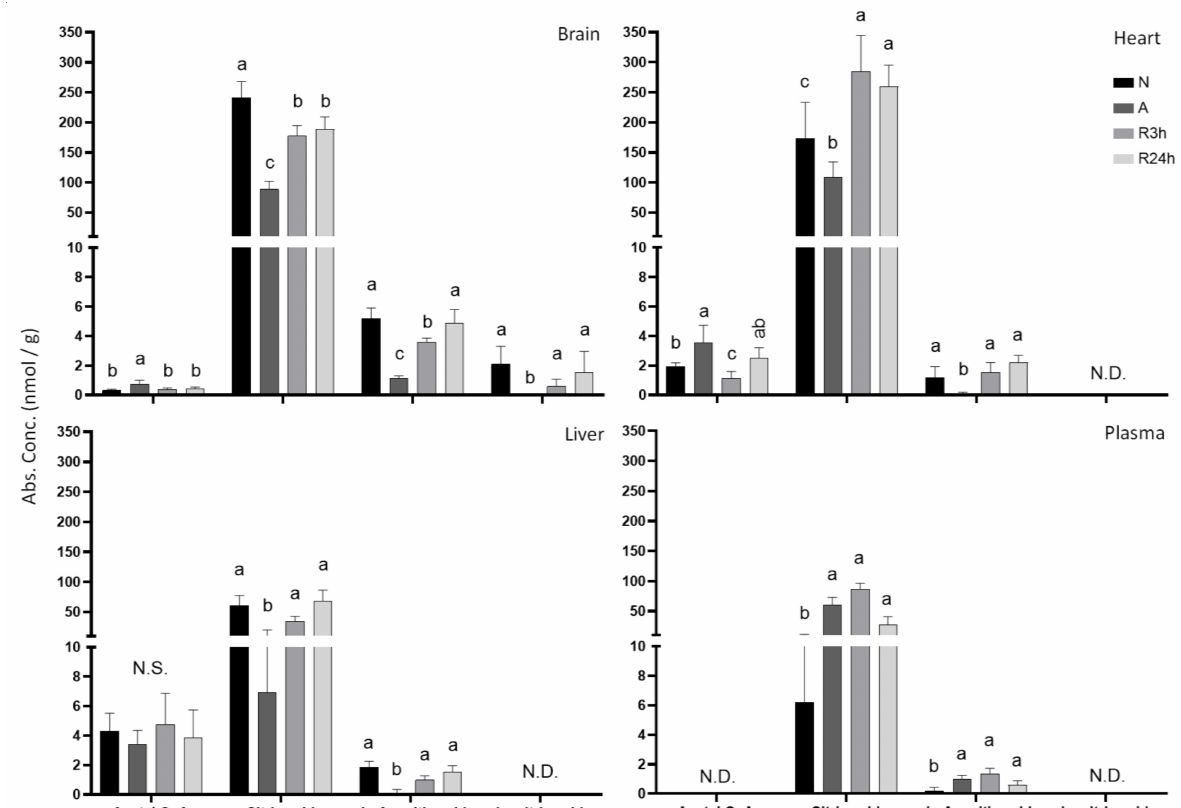
Figure 7. TCA cycle. Graphs of absolute concentrations for detected metabolites involved in the early stages of the TCA cycle of brain, heart, liver, and blood plasma. N, normoxia (control); A, anoxia; R3h, 3 h reoxygenation; R24h, 24 h reoxygenation. Different letters indicate statistical differences between groups calculated using one-way ANOVA with Tukey’s post-hoc ( p -value ≤ 0.05). Data are presented as means ± S.D. Values as reported by